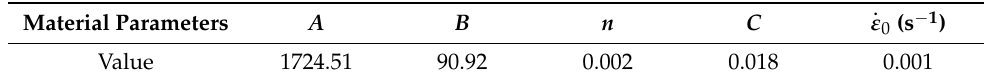
Table 2. The value of material constants in Johnson-Cook model.